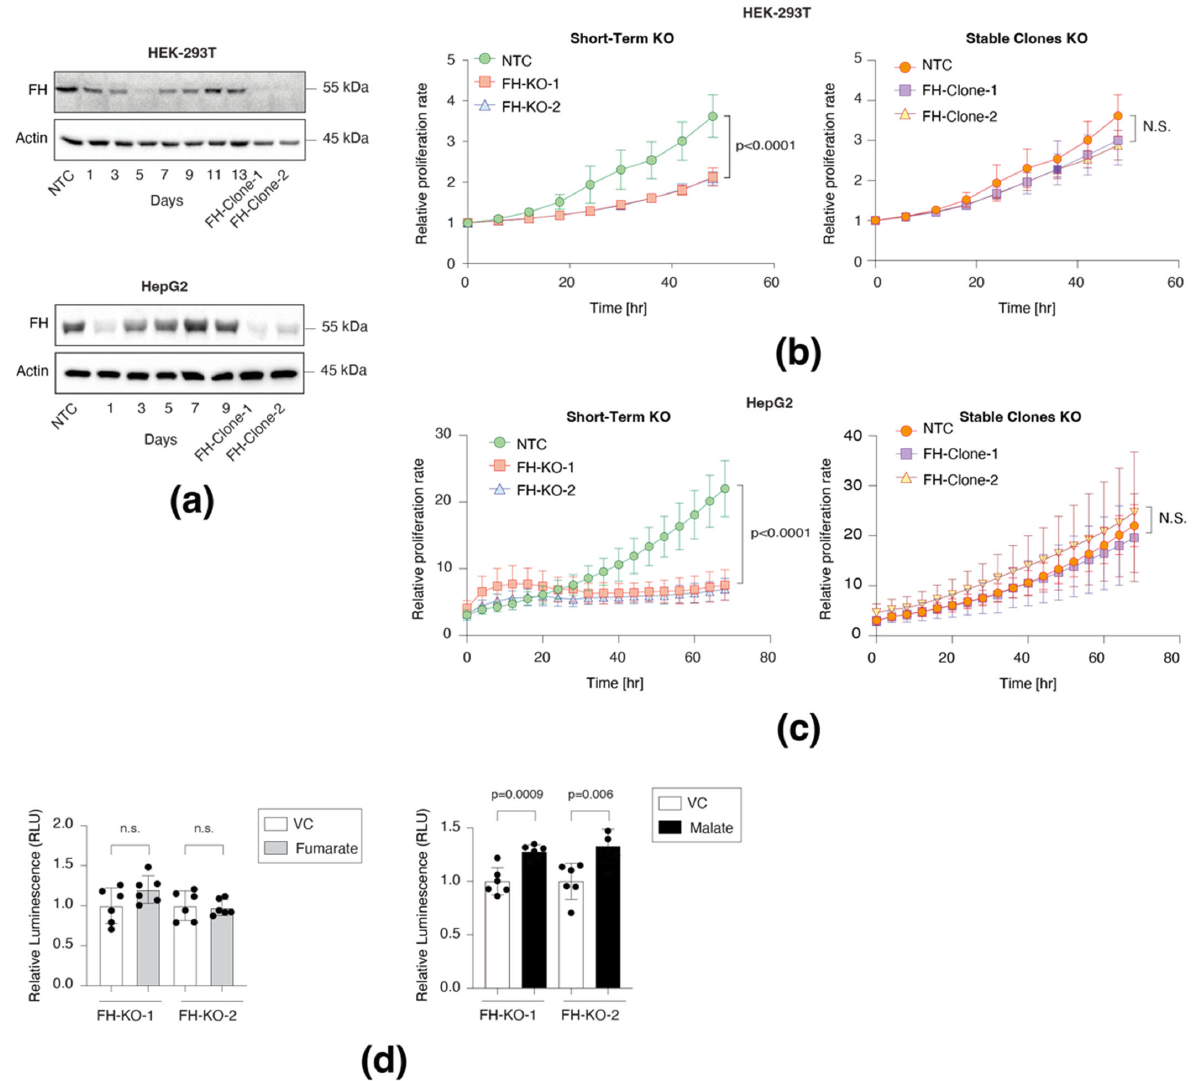
Figure 1. Short ‐ term FH loss inhibits cell proliferation. ( a ) FH expression profile in short ‐ term and long ‐ term knockout cell lines. FH was silenced in HEK ‐ 293T and HepG2 using the CRISPR ‐ Cas9 system and then subjected to 24 h of puromycin selection. At the indicated times post ‐ selection (short ‐ term), the cells were lysed and subjected to immunoblotting using the indicated antibodies. FH ‐ Clone ‐ 1 and FH ‐ Clone ‐ 2 are long ‐ term FH knockout clones, and NTC is a non ‐ targeted control. ( b ) FH was knocked out from HEK ‐ 293T, and then two days post puromycin selection, the cells were subjected to IncuCyte for proliferation analysis and monitored every 2 h up to 48 h (left). Additionally, two stable FH ‐ KO clones were subjected to the same procedure for 48 h (right). NTC is non ‐ targeted control. The analysis of both short ‐ term and long ‐ term was conducted simultaneously. Each bar represents the mean ± SD for n = 6. The p ‐ value was determined by Student’s t ‐ test. N.S. = no statistically significant differences between the samples. ( c ) HepG2 cells were analyzed similarly to HEK ‐ 293T above by IncuCyte for 70 h. Each bar represents the mean ± SD for n = 6. The p ‐ value was determined by Student’s t ‐ test. N.S. = no statistically significant differences between the samples. ( d ) The proliferation rate of FH short ‐ term knockouts was not rescued by supplementing fumarate (mono ‐ ethyl fumarate, left) and only partially rescued by malate (diethyl malate, right). FH was knocked out in HEK ‐ 293T cells and then treated with vehicle control (DMSO, VC), fumarate (250 μ M), or malate (250 μ M) for three days. The p ‐ values were determined by Student’s t ‐ test. The uncropped Western Blot images can be found in Figure S4.